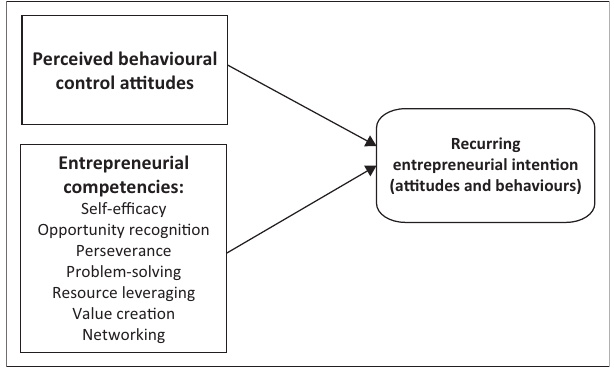
FIG URE 3: The relationship between entrepreneurial competencies and recurring entrepreneurial